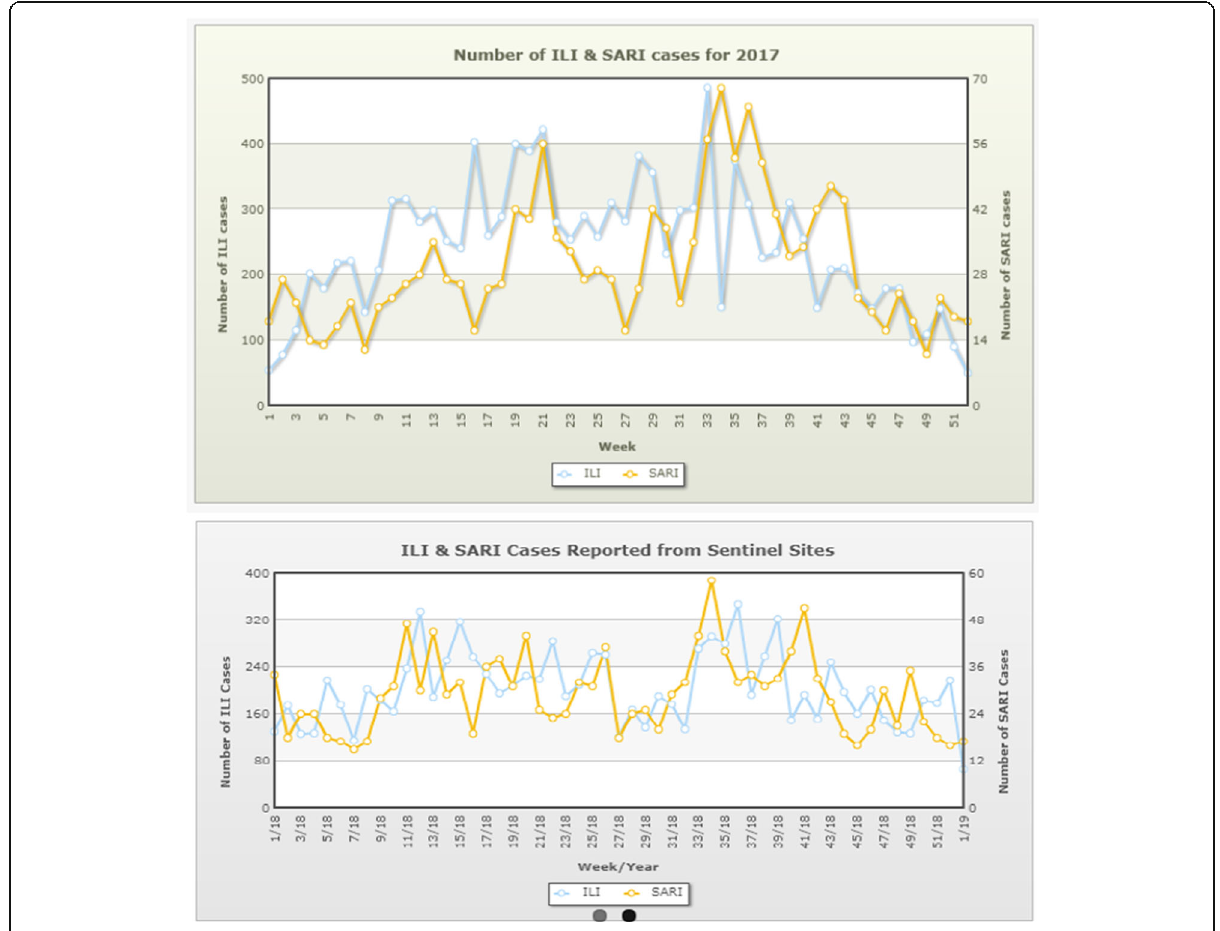
Fig. 2 Number of ILI and SARI cases in 2017 and 2018. Reproduction permitted. Source: RCDC Fluview weekly reports [30]